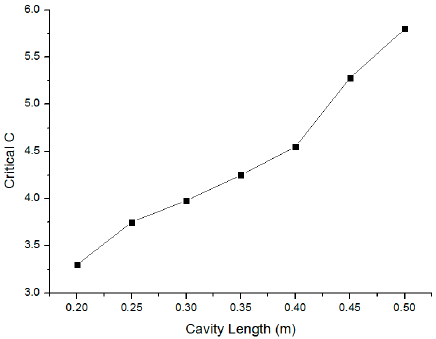
h when the injection current is 52.5 mA. Figure 5. 0